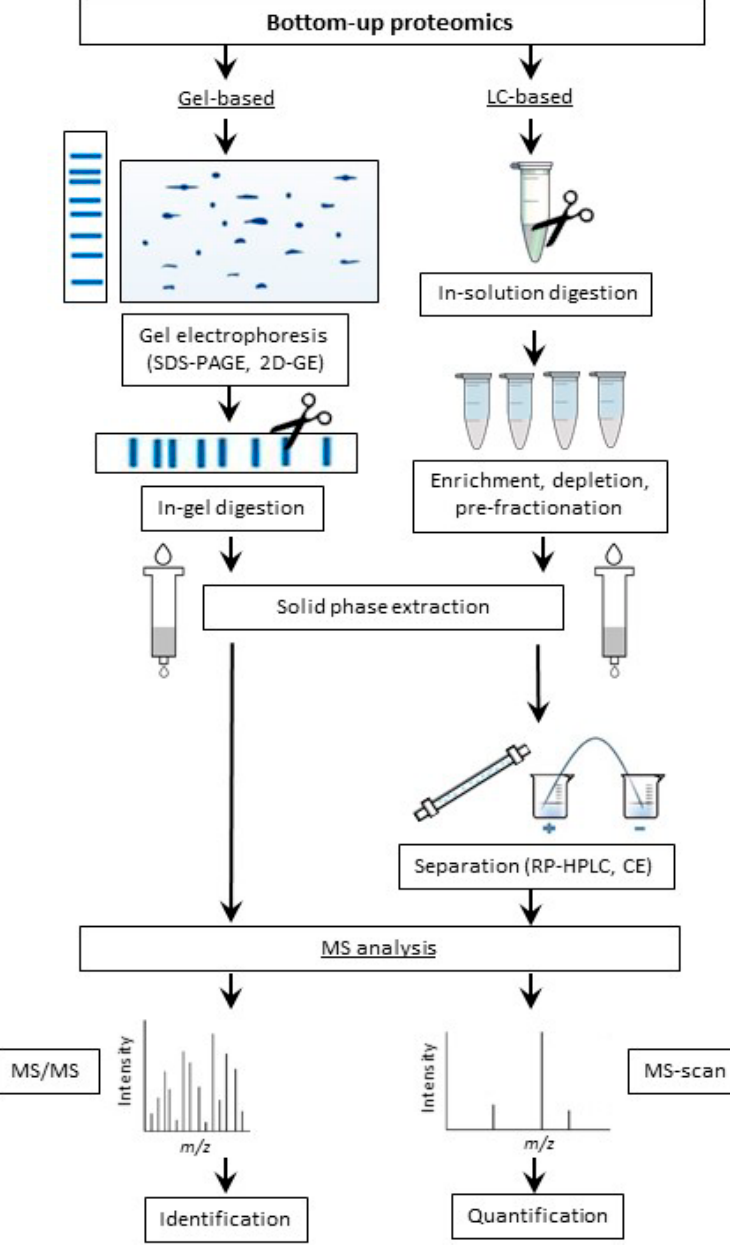
Figure 2. The overview of the gel- and LC-based workflows in bottom-up proteomics. The scissors denote enzymatic proteolysis.